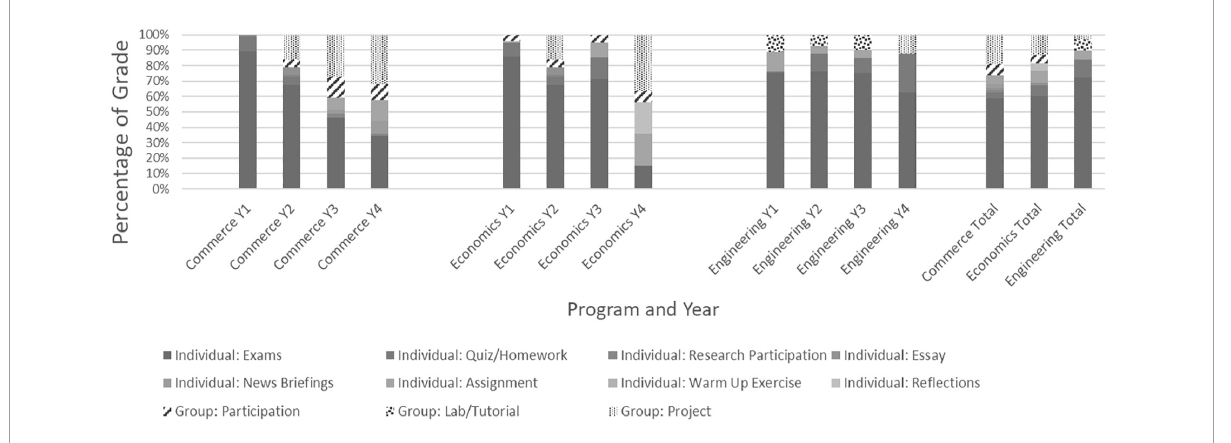
FIGURE1 Composition of evaluation criteria by program of study and